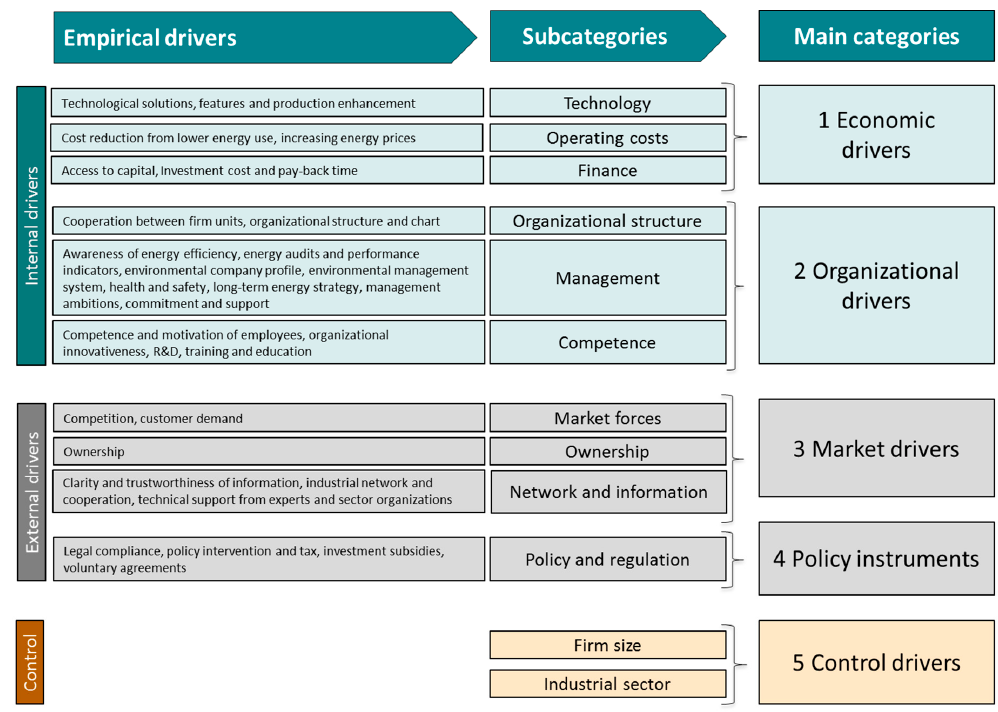
Figure 6. Categorization of drivers to energy efficiency.